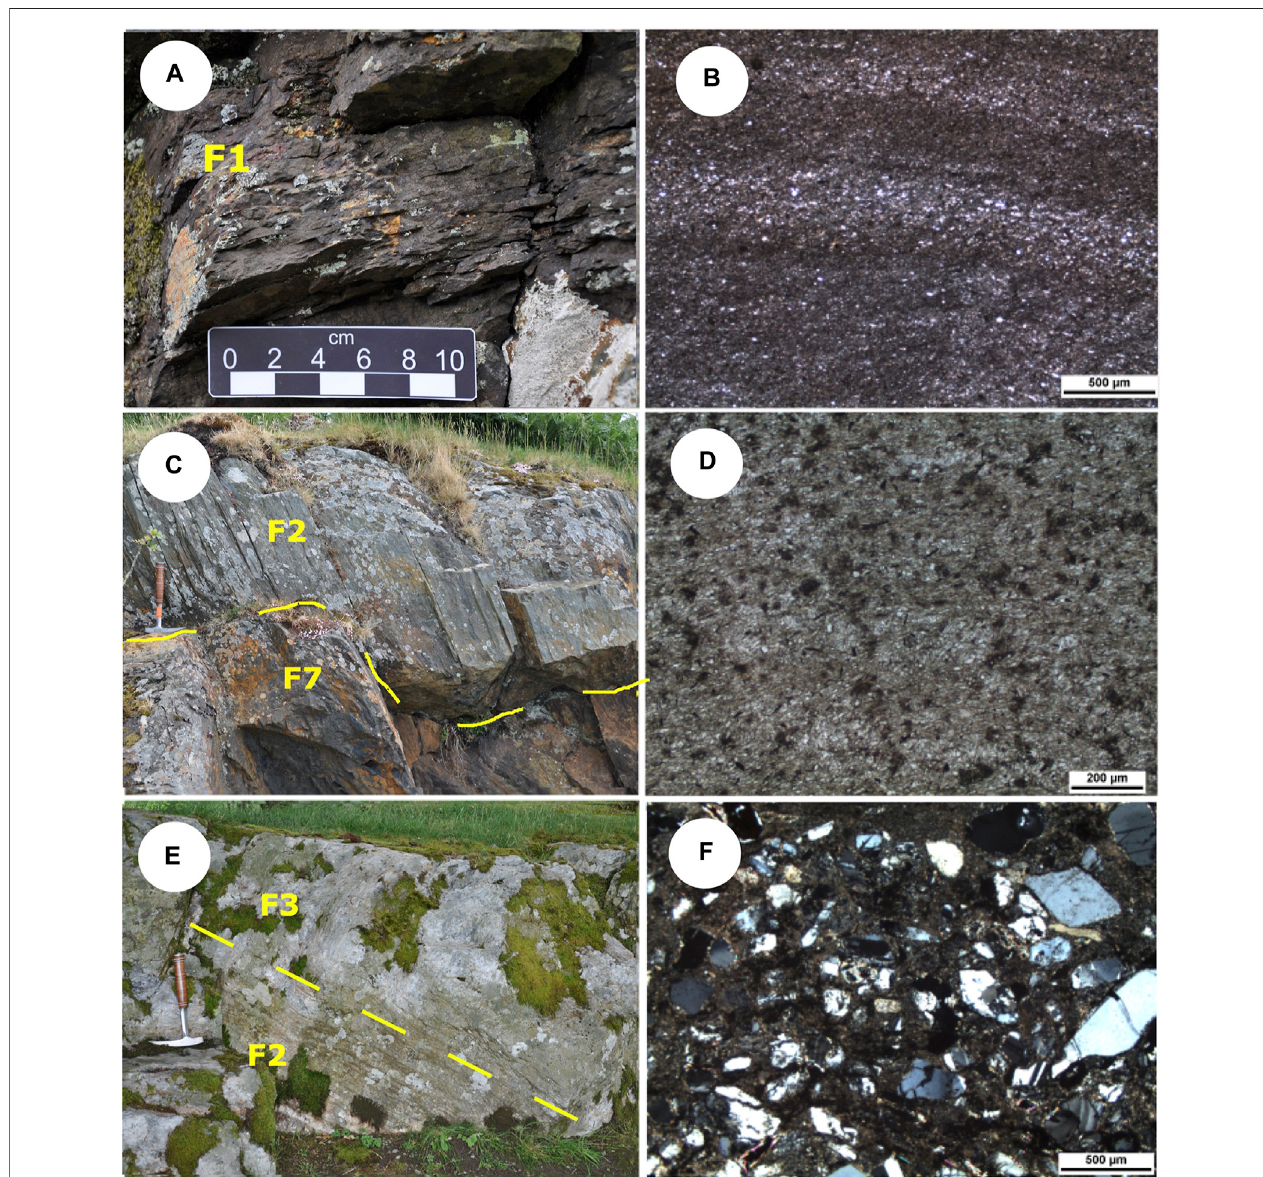
FIGURE 4 | (A) F1 wavy laminated sandy siltstone outcrop at Betws Garmon. (B) Photomicrograph of F1 silt and very fi ne grained sand laminae of quartz and Fe- silicate (PPL). Sample HC-18-15 (C) F2 sharply overlying Fe-grainstone (F7) at Betws Garmon. Note near-vertical cleavage of the F2 slate. Hammer for scale is 30 cm in length; (D) F2 photomicrograph of low grade metamorphically altered shale (phyllite; PPL). Sample BG-18-01 (E) F3 outcrop separated by yellow line above laminated F2. Hammer for scale 30 cm (F) Photomicrograph of F3 Lithic and feldspar-rich grains. Note undulose and uniform extinction in quartz grains (XPL). Sample BG-